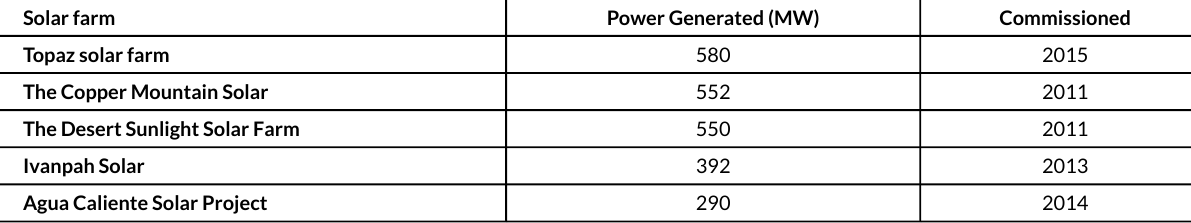
Table 8. The largest five solar farms in United States